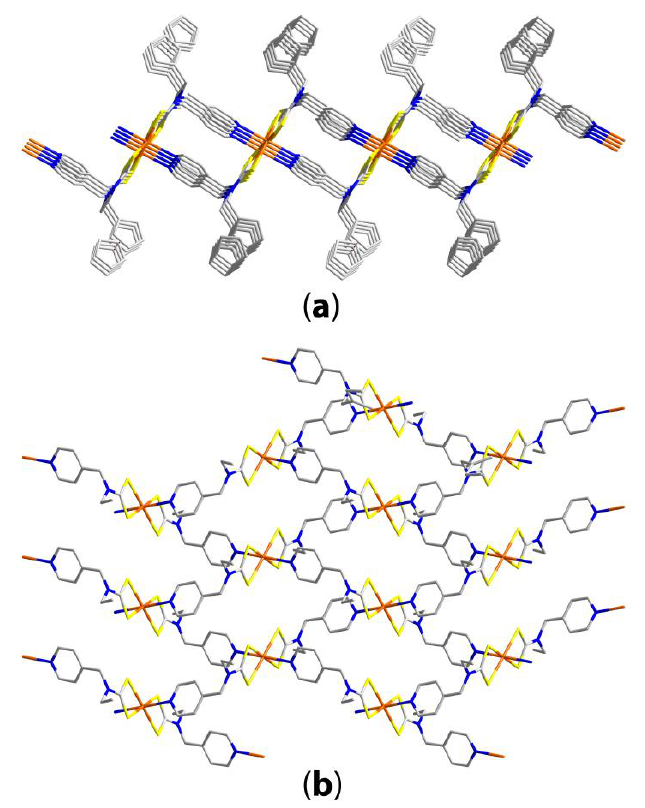
Figure 10. Two views ( a ) side-on and ( b ) perpendicular to the two-dimensional layer in the structure of {Zn[S 2 CN(CH 2 ferrocenyl)CH 2 (4-py)] 2 } n ( 100 Table 4. Summary of the general features of Cd(S 2 CNRR’) 2 structures 101 – 141 .